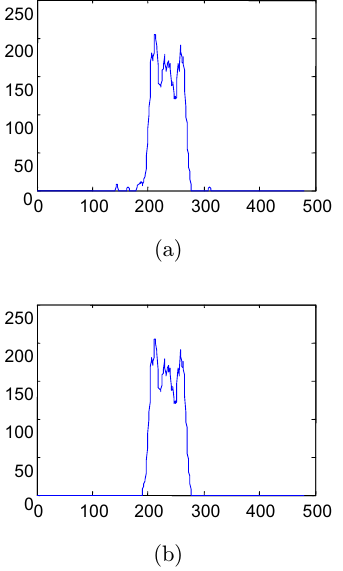
Fig. 6. Horizontal projection of Fig. 4(f) and ¯ltering 0. (a) Horizontal projection curve and (b) after noises ¯ltering out.